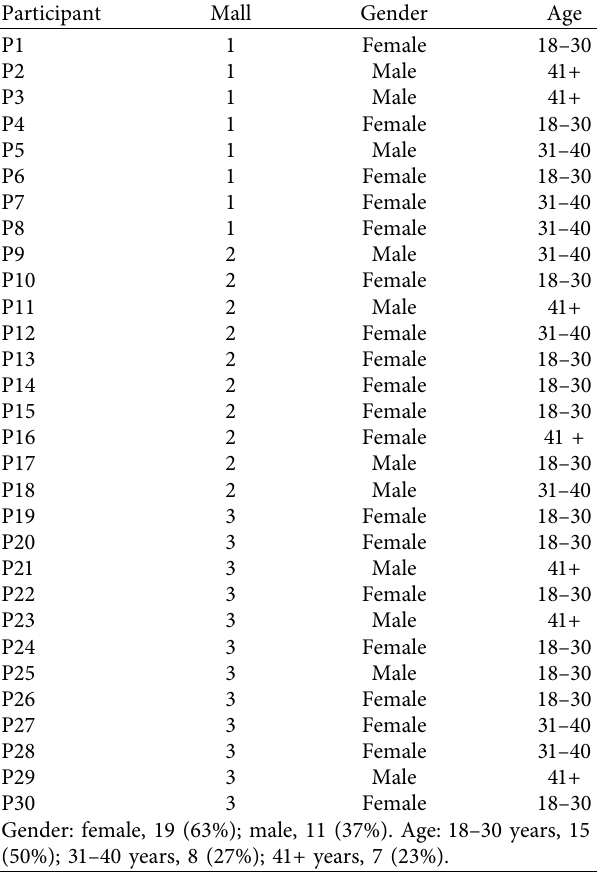
amount of time it takes for you to get to the destination that you want to arrive at.”